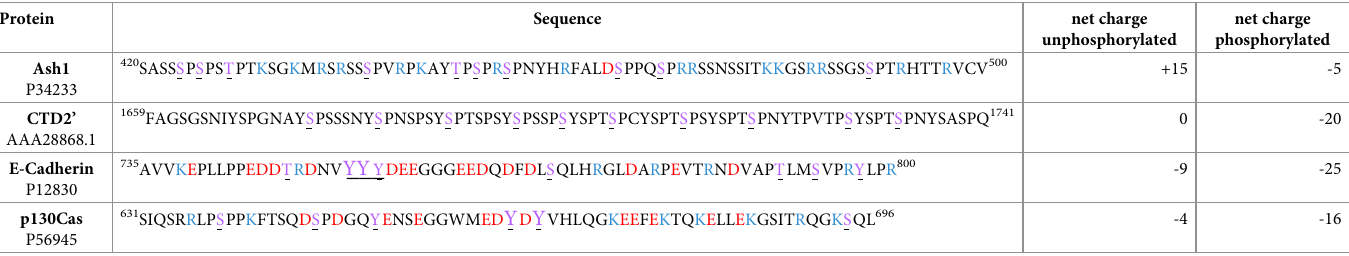
Table 1. Primary sequences of IDPs investigated in MD simulations: Ash1, CTD2’ of RNA polymerase II, the cytosolic domain of E-Cadherin, and p130Cas with UniProt IDs shown below the name of the IDPs. The positively and negatively charged residues are colored in cyan and red, respectively. The phosphorylation sites are underlined in purple. For E-Cadherin and p130Cas, the most biologically relevant two phosphorylation sites are shown in larger font size. The net charges of fully unpho- sphorylated and phosphorylated forms of these IDPs are shown in the right panel. Protein